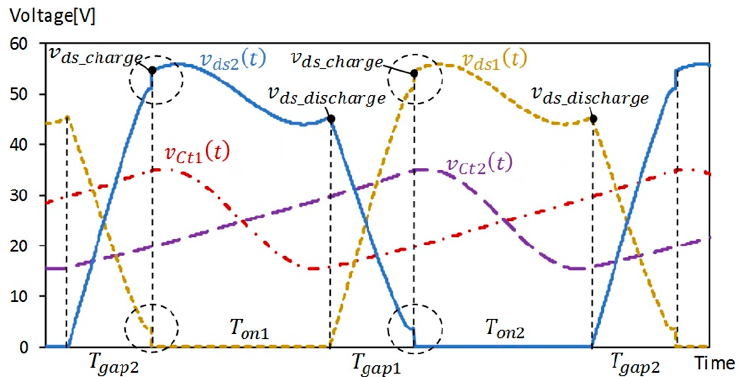
Figure 11. Two different GaN HEMT bias for the gap state of the synchronous rectifier transistors. ( a ) V GS = 0 V and ( b ) V GS < 0 V.